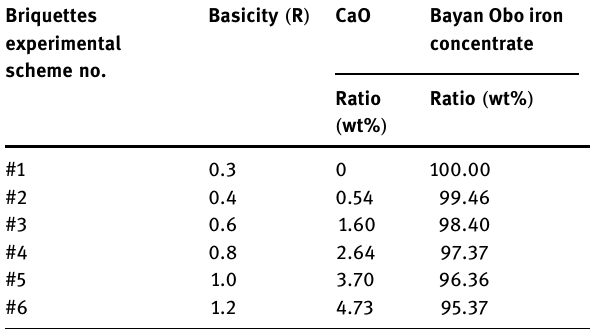
Table 2: The addition of CaO to briquettes with di ff erent basicity Briquettes experimental scheme